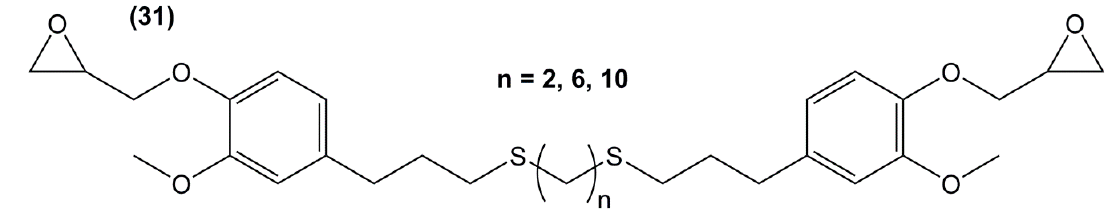
Figure 22. Eugenol-based epoxy prepolymers synthesized by Zou et al. [165].